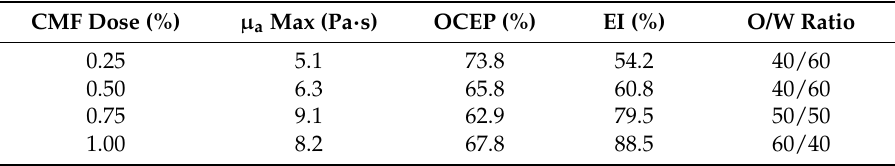
Table 2. Summary of emulsions with the highest µ a for each CMF dose. CMF Dose